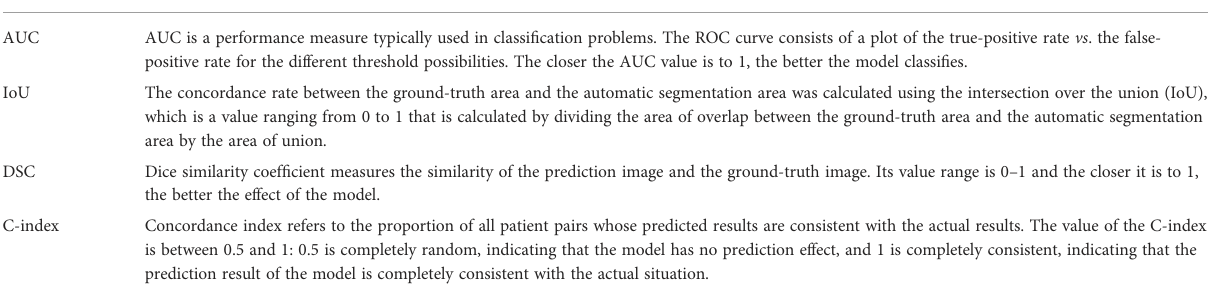
TABLE 1 Performance measure terminologies.